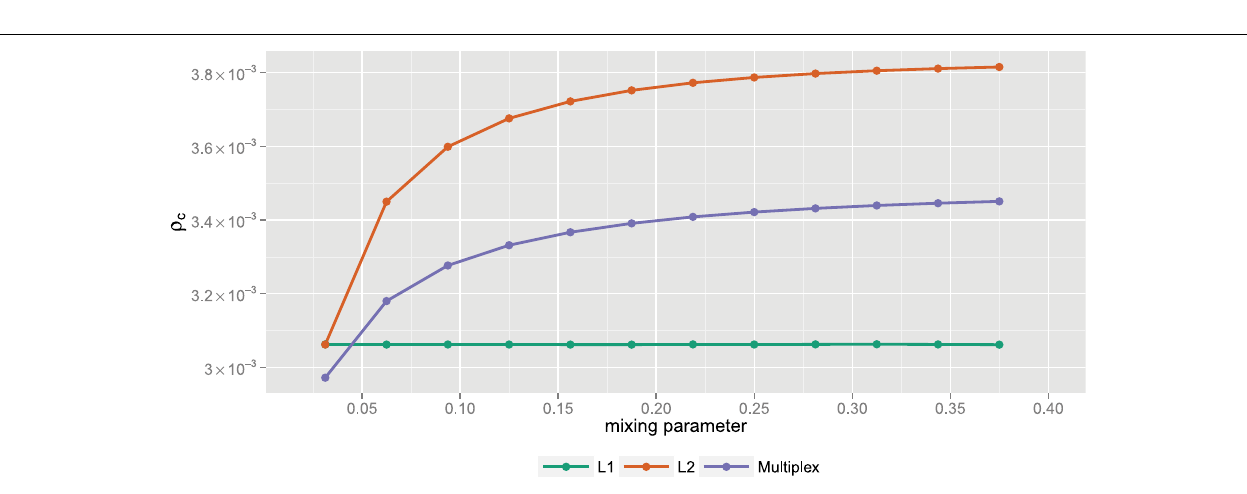
efficiency of both layers and consequently the coupling of layers is